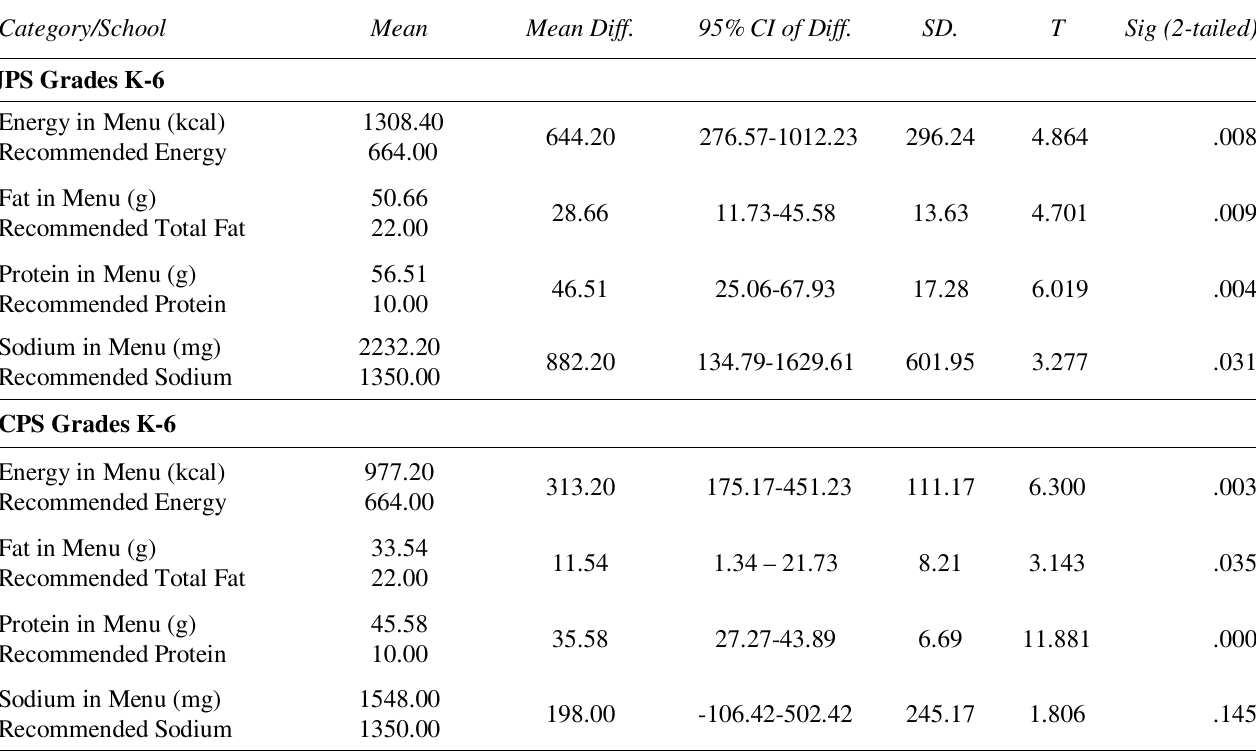
Table 9: Differences between nutrients in the regular menu and the recommended intake of nutrients for Grades K-6 Category/School Mean Mean Diff. 95% CI of Diff. SD. T Sig (2-tailed)